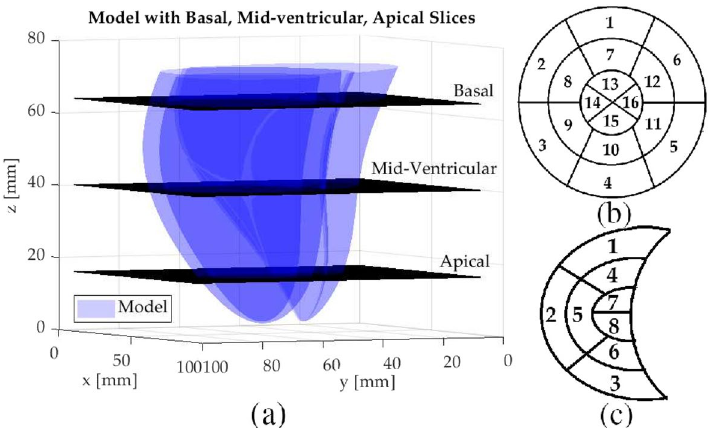
Figure 1. ( a ) The intersection of the biventricular cardiac model and three MR slice planes corresponding to the basal, mid-cavity, and apical sections. ( b ) 16-point LV model. ( c ) 8-point RV model. The POI locations of the LV and RV segments on the cardiac surface, identified by the indexes in the corresponding 16-point and 8-point models are as follows: Anterior : LV1, LV7, LV13, RV1, RV4, RV7; Anteroseptal : LV2, LV8; Septal : LV14; Inferoseptal : LV3, LV9; Inferior : LV4, LV10, LV15, RV3, RV6, RV8; Lateral : LV16, RV2, RV5; Inferolateral : LV5, LV11; Anterolateral : LV6, LV12.